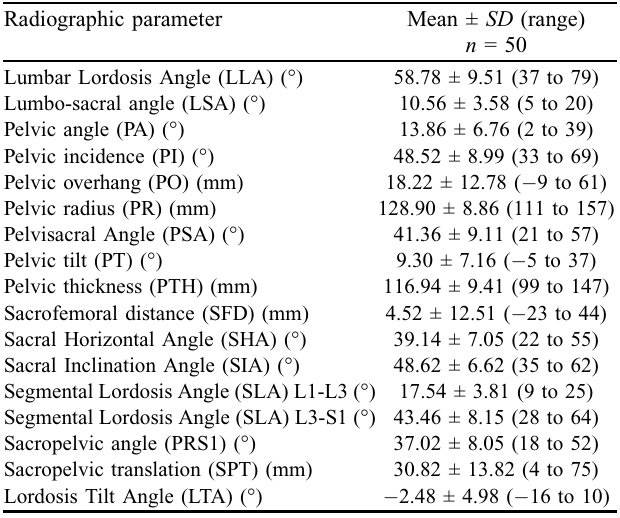
Table 2. Findings on sagittal spino-pelvic radiographs among study